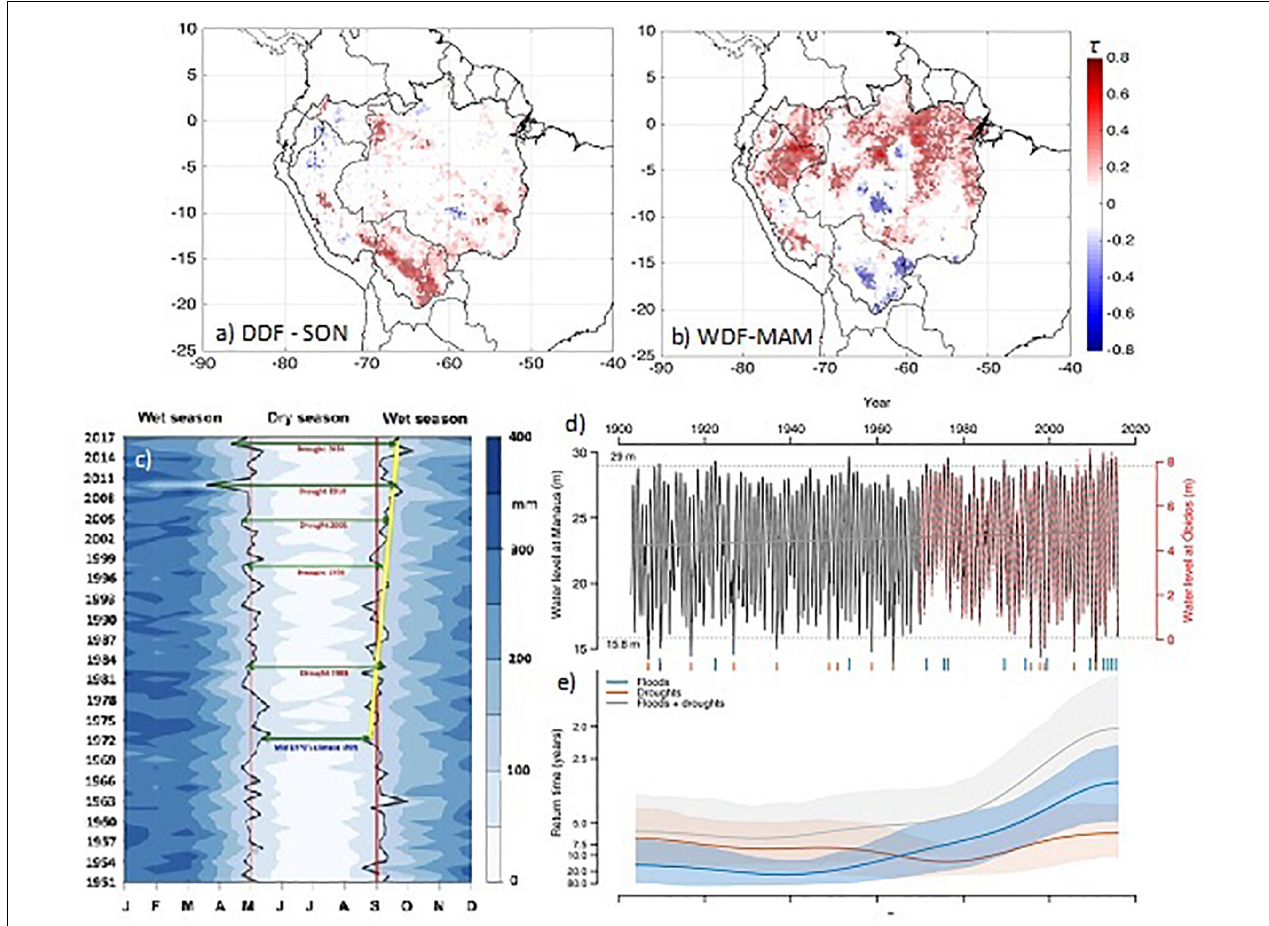
FIGURE 3 | Spatial distribution of Kendall coefficient values ( p < 0.05 are indicated with a dark dot) showing the trend for: (A) 1981–2017 DDF during SON season and (B) 1981–2017 WDF during MAM season. DDF (WDF) are defined as days with rainfall < 1 mm ( > 10 mm). Adapted from Espinoza et al. (2019a). © Climate Dynamics. Reprinted by permission from Springer Nature. (C) Hovmoller diagram showing monthly rainfall (1951 to 2017) for southern Amazonia (mm/month). The isoline of 100 mm/month is an indicator of dry months in the region (Sombroek, 2001). Drought years are indicated with green lines. Red lines show the average onset and retreat of the rainy season [Adapted from Marengo et al. (2011) and updated to 2017 in Marengo et al. (2018b). © American Geophysical Union. Used with permission]. Yellow line shows the trend to a longer dry season after the mid 1970’s climate shift. (D) Daily water level of Negro River at Manaus (black; 1903–2015) and Amazon River at Óbidos (red; 1968–2015). The horizontal dotted lines denote the thresholds used to define drought (15.8 m) and flood (29.0 m) events from the Negro River daily water level data. The resulting events are indicated by orange (droughts) and blue (floods) vertical ticks at the bottom of the panel. (E) Time-varying frequency of the identified droughts and floods between 1903 and 2015. Adapted from Barichivich et al. (2018). CC licence. © American Association for the Advancement of